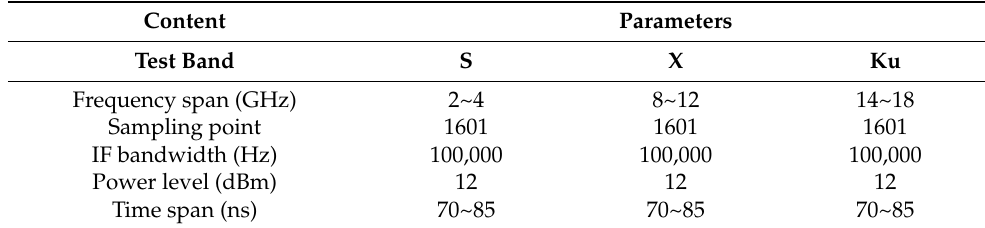
Figure 1. Environment of the anechoic chamber: ( a ) the spatial arrangement during the test, ( b ) a photo of the test.